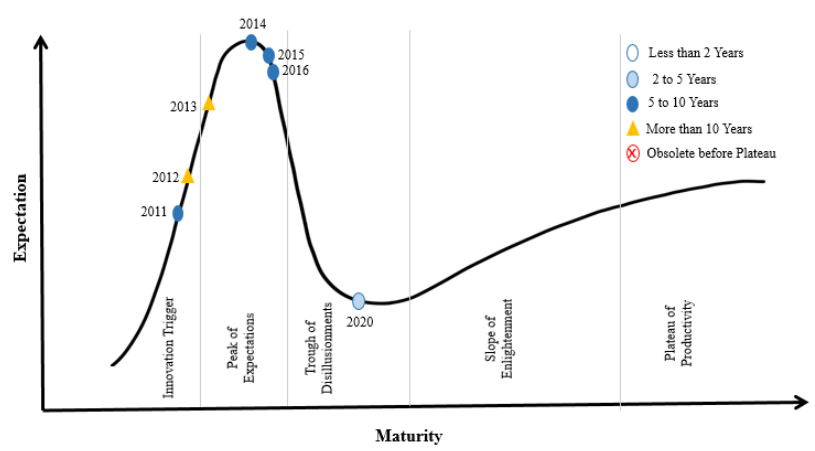
Fig. 1. IoT evolution on Gartner hype cycle of IoT since